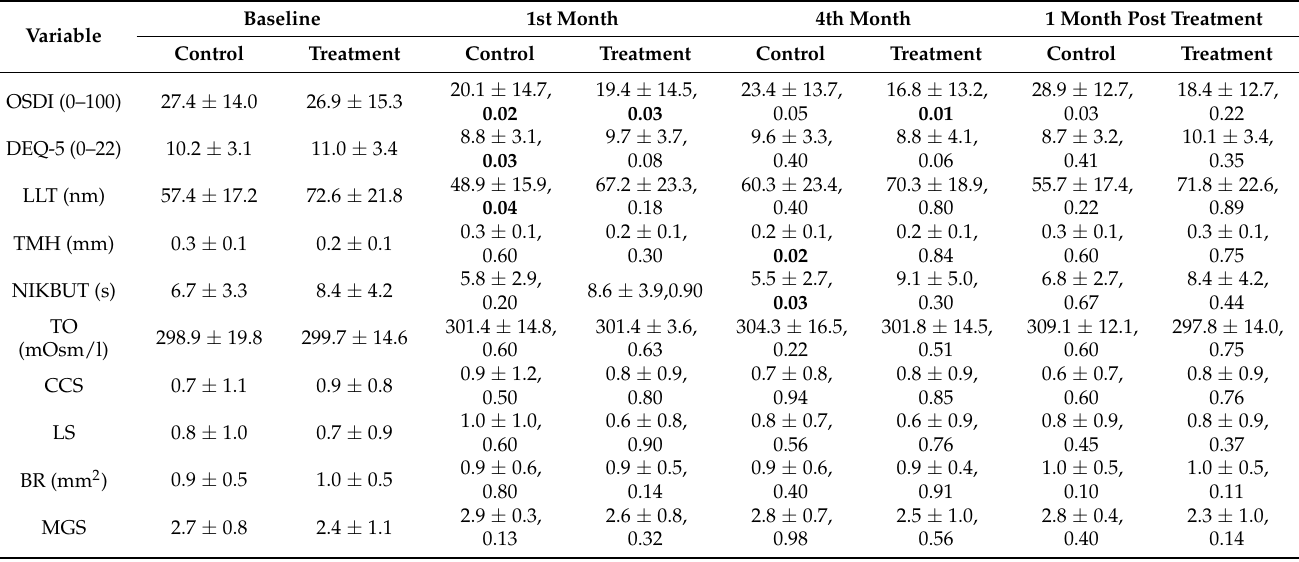
Table 1. Summary statistics for clinical variables in the treatment and control groups at each time point. p -Values indicate a comparison between the time point and the